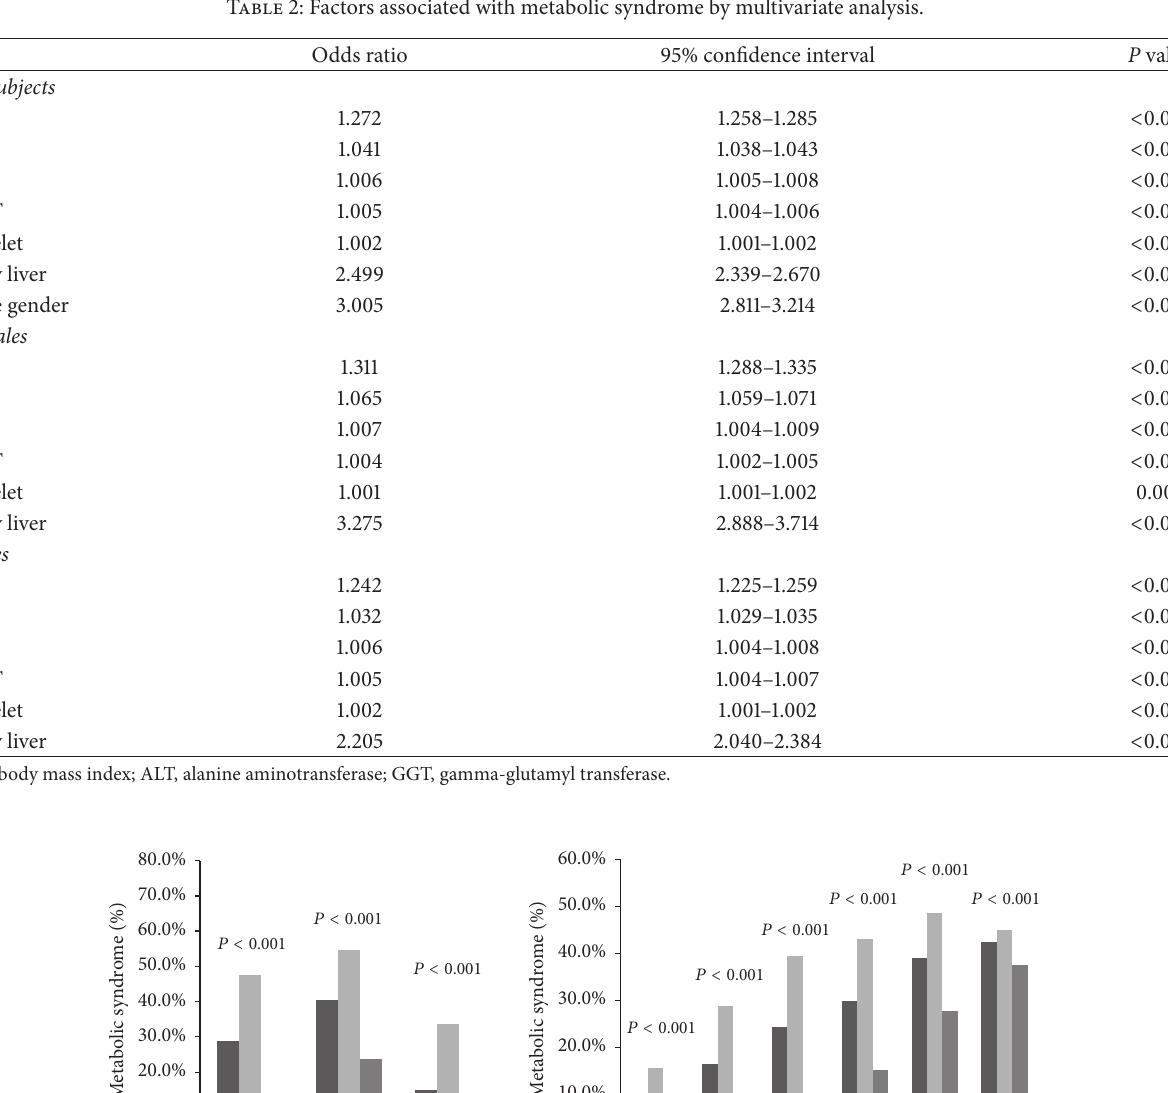
Table 2: Factors associated with metabolic syndrome by multivariate analysis.